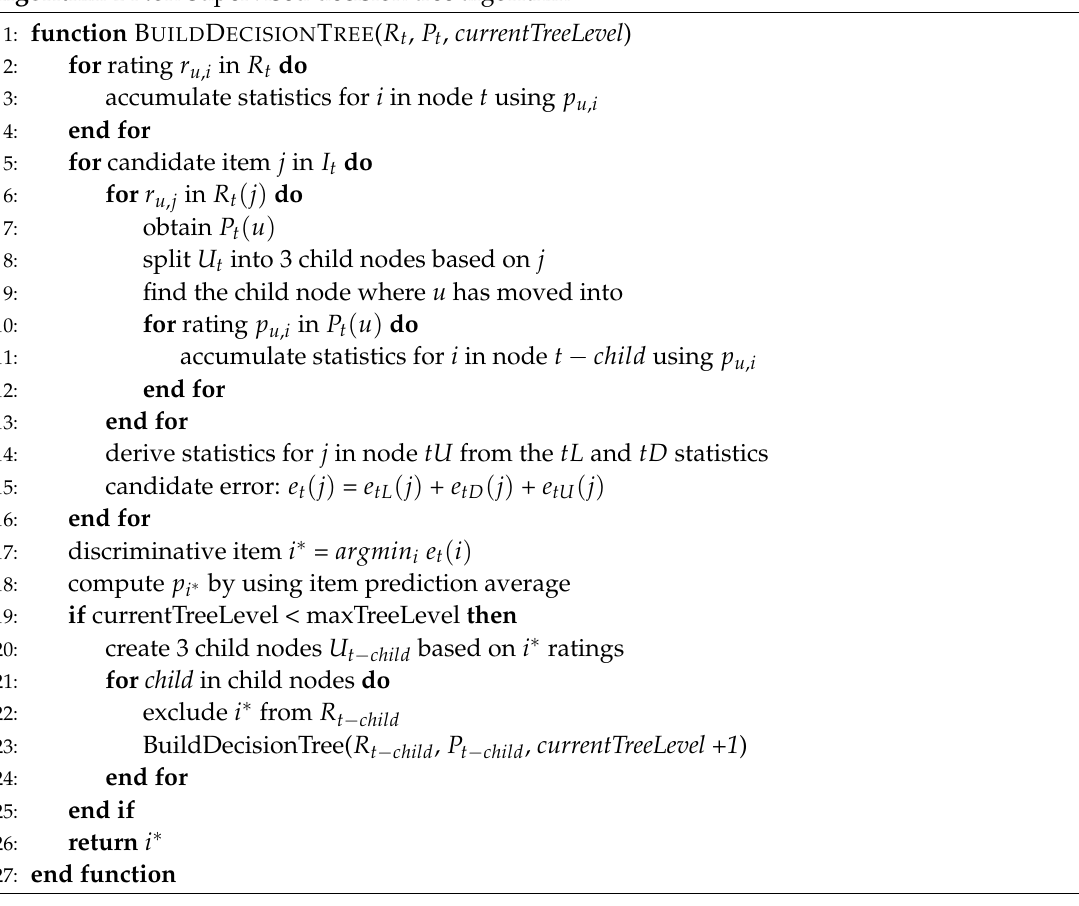
Algorithm 1 Non-supervised decision tree